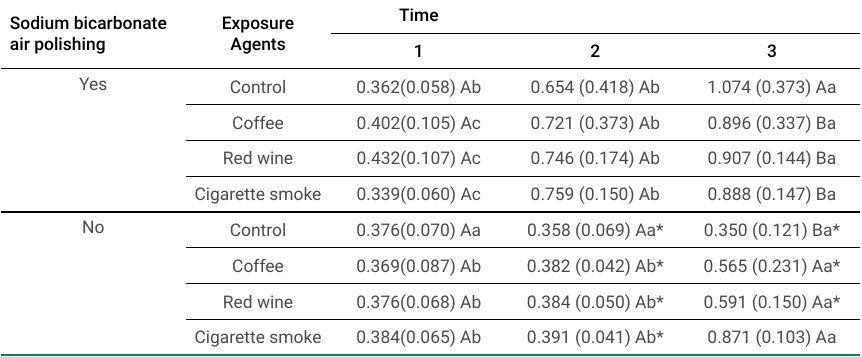
Table 2. Surface roughness means (Standard Deviations) according to the groups and different